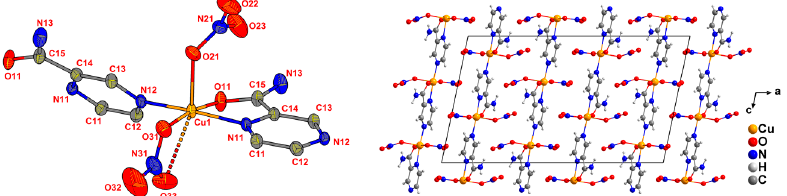
Figure 1. ORTEP representation (50% probability level) of the molecular entity within the structure of 1 ∞ [Cu(Ina) 2 (NO 3 ) 2 ] ( 2 ) ( left ); packing along the c axis in the crystal ( right ); H atoms were omitted for clarity.